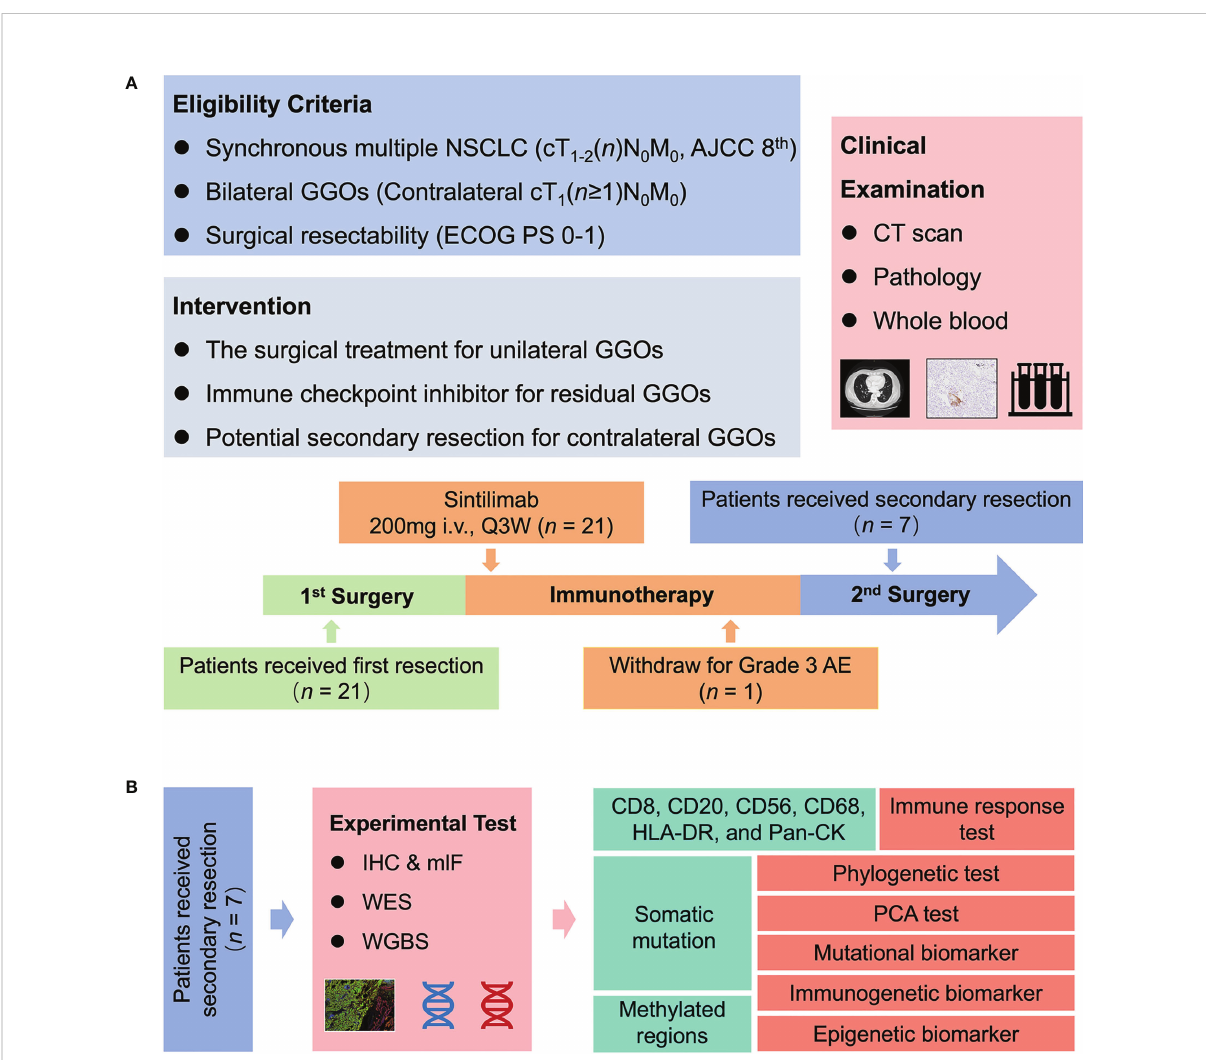
FIGURE 1 Trial schema. (A) Twenty-one patients with bilateral GGOs received Sintilimab (200mg i.v., Q3W) for up to 10 cycles at six weeks or later after surgical resection. During the use of Sintilimab, the radiological evaluation was performed at every three cycles within treatment period